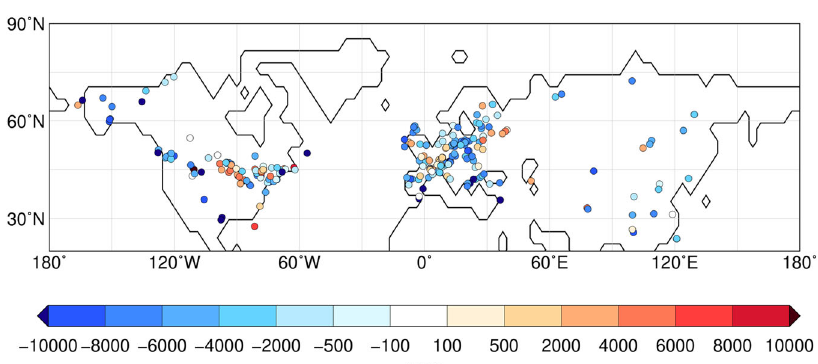
Fig. 3 | Difference in simulated and reconstructed timing of the minimum in openness. Difference in the timing of the minimum in the landscape openness between the model and the reconstructions for each site. For the reconstructions, the minimum in openness has been calculated on the basis of the biome af fi nity scores (Methods).For thispurpose, the highest af fi nity scorewithin the non-forest biomes has been subtracted from the highest af fi nity score within the forest biomes, re fl ecting the degree in openness. When this difference is largest, the openness is at its minimum and the plant functional type (PFT) sample is most